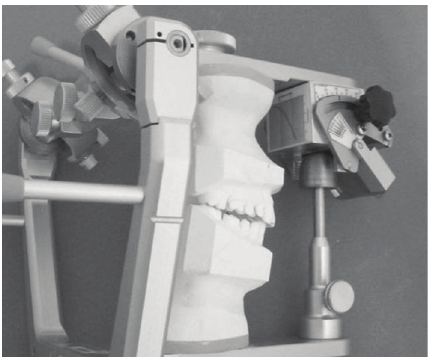
Figure 8: The prototype of the novel incisal table, mounted on a commercial